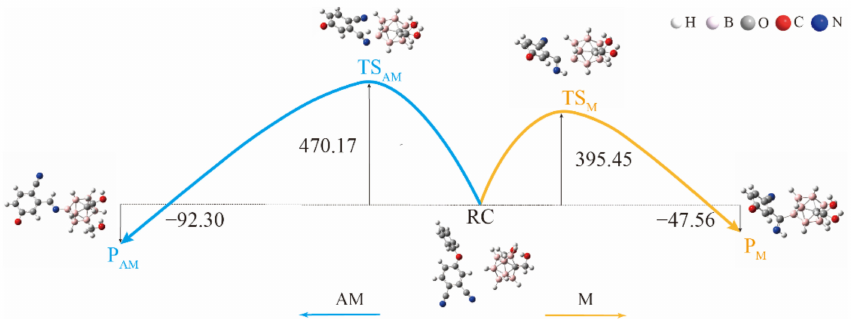
Figure 7. Two possible pathways of hydroboration of BPh with QCB (the blue line indicates path AM; the yellow line is for path M; the energies are given kJ/mol), and products (PAM and PM) of the two pathways are also shown. All calculations are implemented via the Gaussian09 software